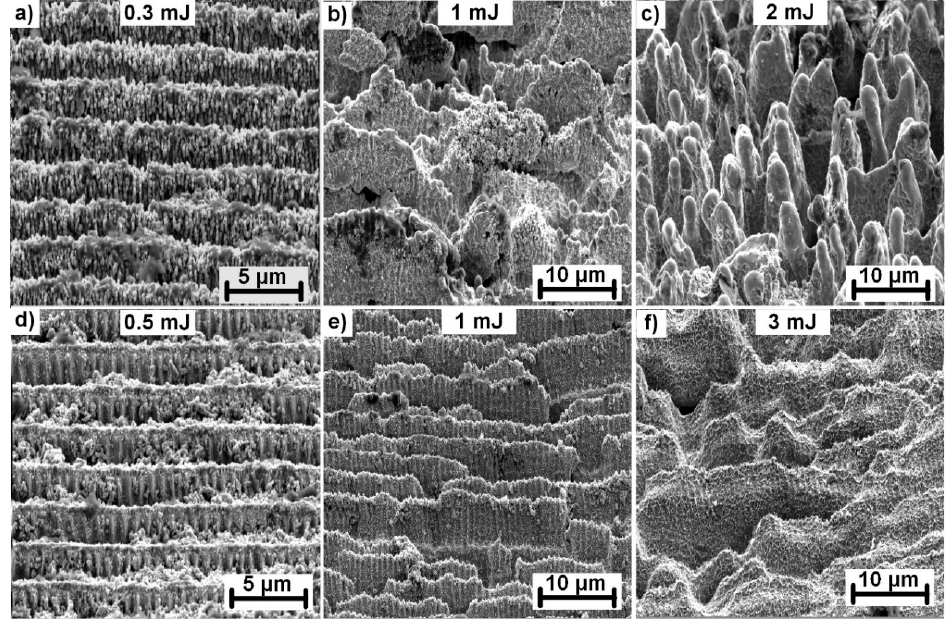
Figure 5 . Structure evolution in Invar ( a–c ) and tungsten ( d–f ) with increasing pulse energy. The surface was irradiated with 1000 consecutive laser pulses. All images were captured with the sample tilted 55°.